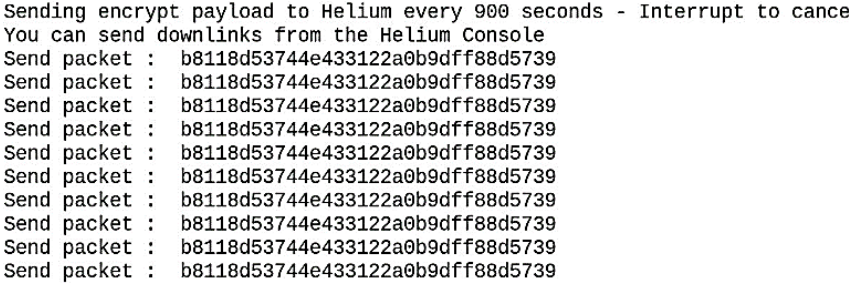
Figure 22. Node sending encrypted data.